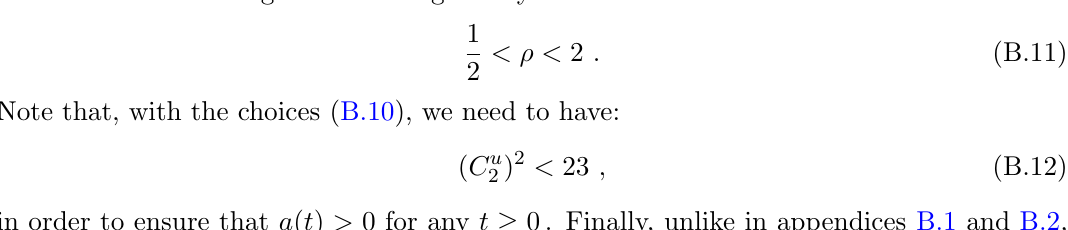
(cid:0) (cid:1) ’ ( t ) ; (cid:18) ( t ) for the same values of the constants as in (cid:12)gure